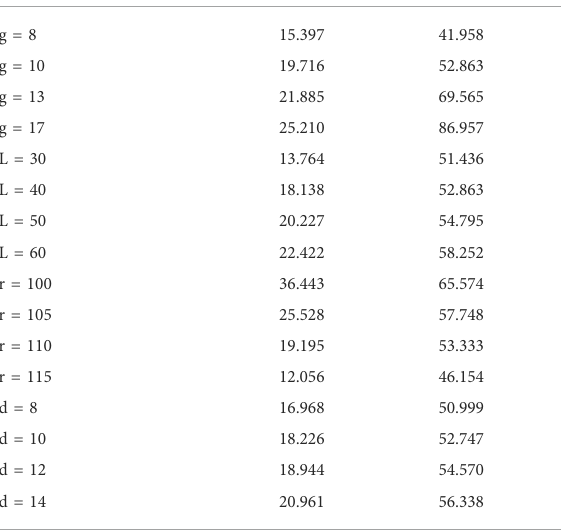
TABLE 1 Quality factor (FOM) corresponding to different geometric